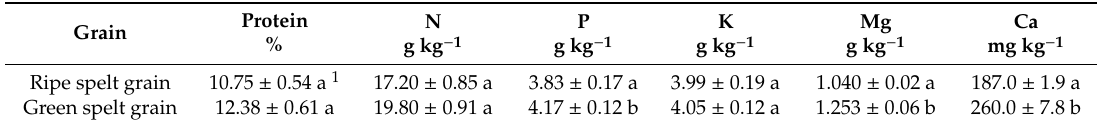
Table 1. The content of protein and macroelements in the grain of